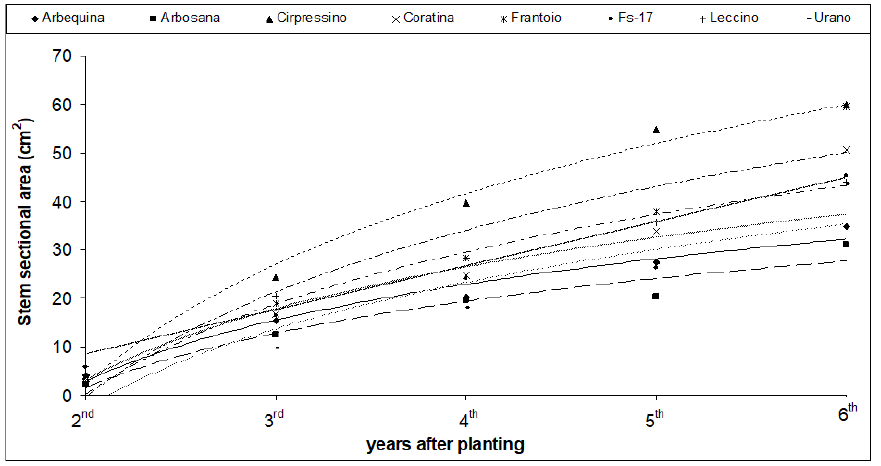
Figure 7. The von Bertalanffy functions of stem sectional area (A, cm 2 ) for eightcultivars from secondto sixth year after planting.